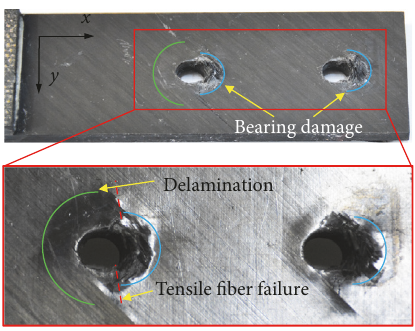
Figure7:Failuremorphologyofthetoplaminateunderfailureload.